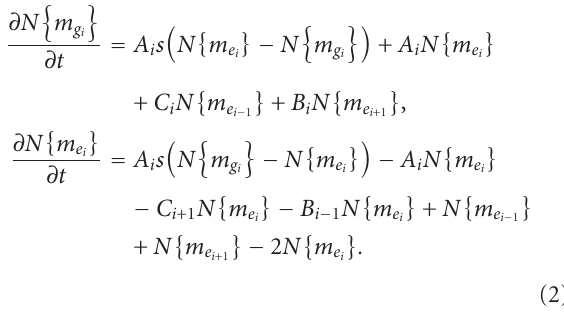
mass; σ k = 1 ∗ 10 − 15 m 2 —Cs-atoms collision cross section; d = 1 ∗ 10 − 2 m—thin-cell window